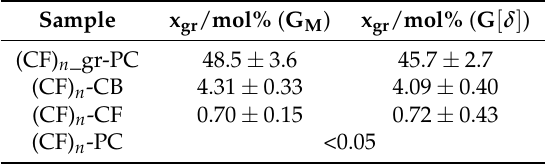
Table 1. Mole fraction of graphitic carbon in poly(carbon monofluoride) samples determined by uncoupled 13 C enhanced CPMG NMR at 16 2 ⁄ 3 kHz MAS determined using two models for the gain function. The G M and G [ δ ] functions are given in the Supplementary